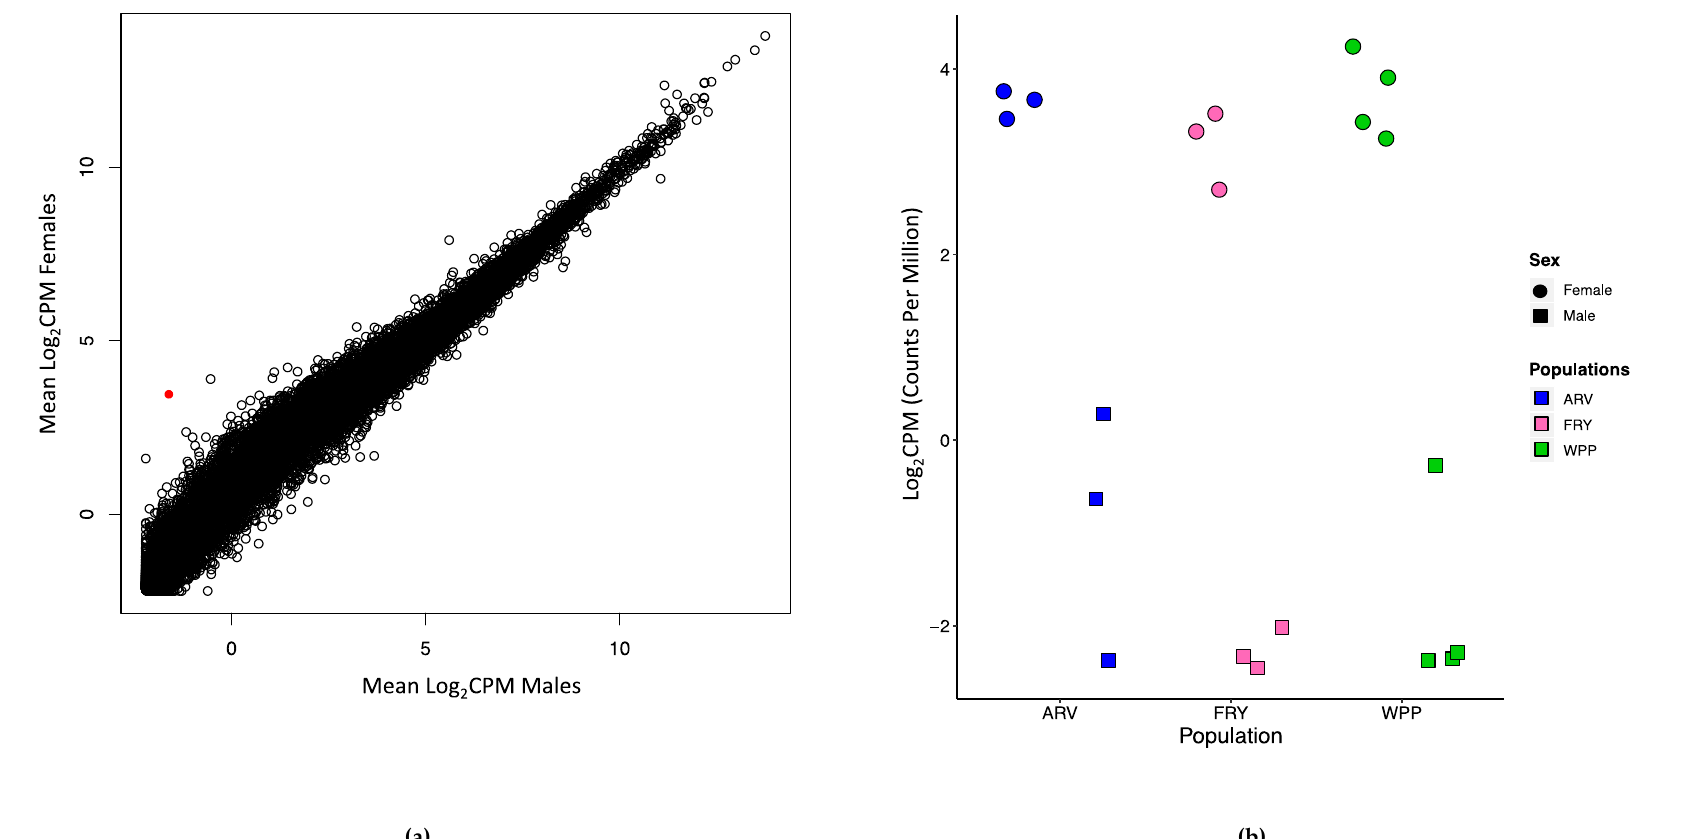
Figure 3. Scatterplot showing the Log 2 CPM (log-transformed counts per million) values between ( a ) males and females, with the red point indicative of the gene FRMD7 . ( b ) Scatterplot showing the Log 2 CPM values for the gene FRMD7 in males and females within each population. There was significant differential gene expression in FRMD7 between the sexes (circles for females and squares for males) across all populations sampled from different geographic locations.